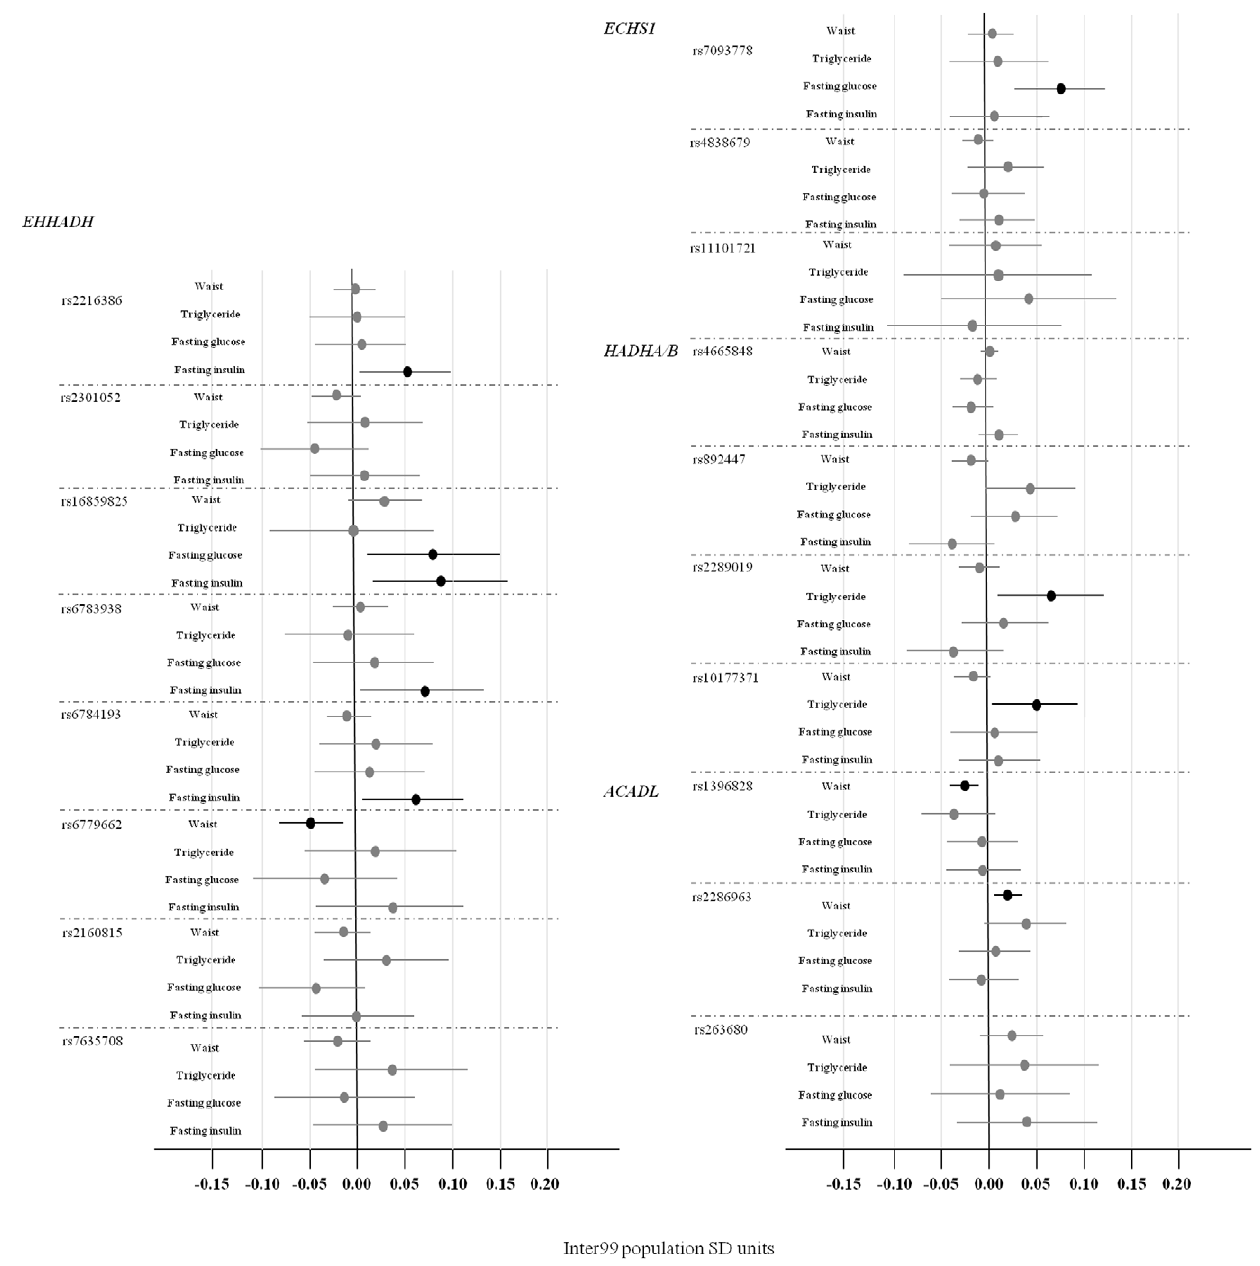
Figure 2. Quantitative trait analyses of NAFLD-related traits in ( n =4,567) glucose-tolerant Danes. Standardized Inter99 population SD units for NAFLD-related traits: waist circumference, fasting serum triglycerides, fasting plasma glucose, and fasting serum insulin. Calculated as mean(trait)/SD(trait). The analyses were adjusted for age, sex, and BMI.